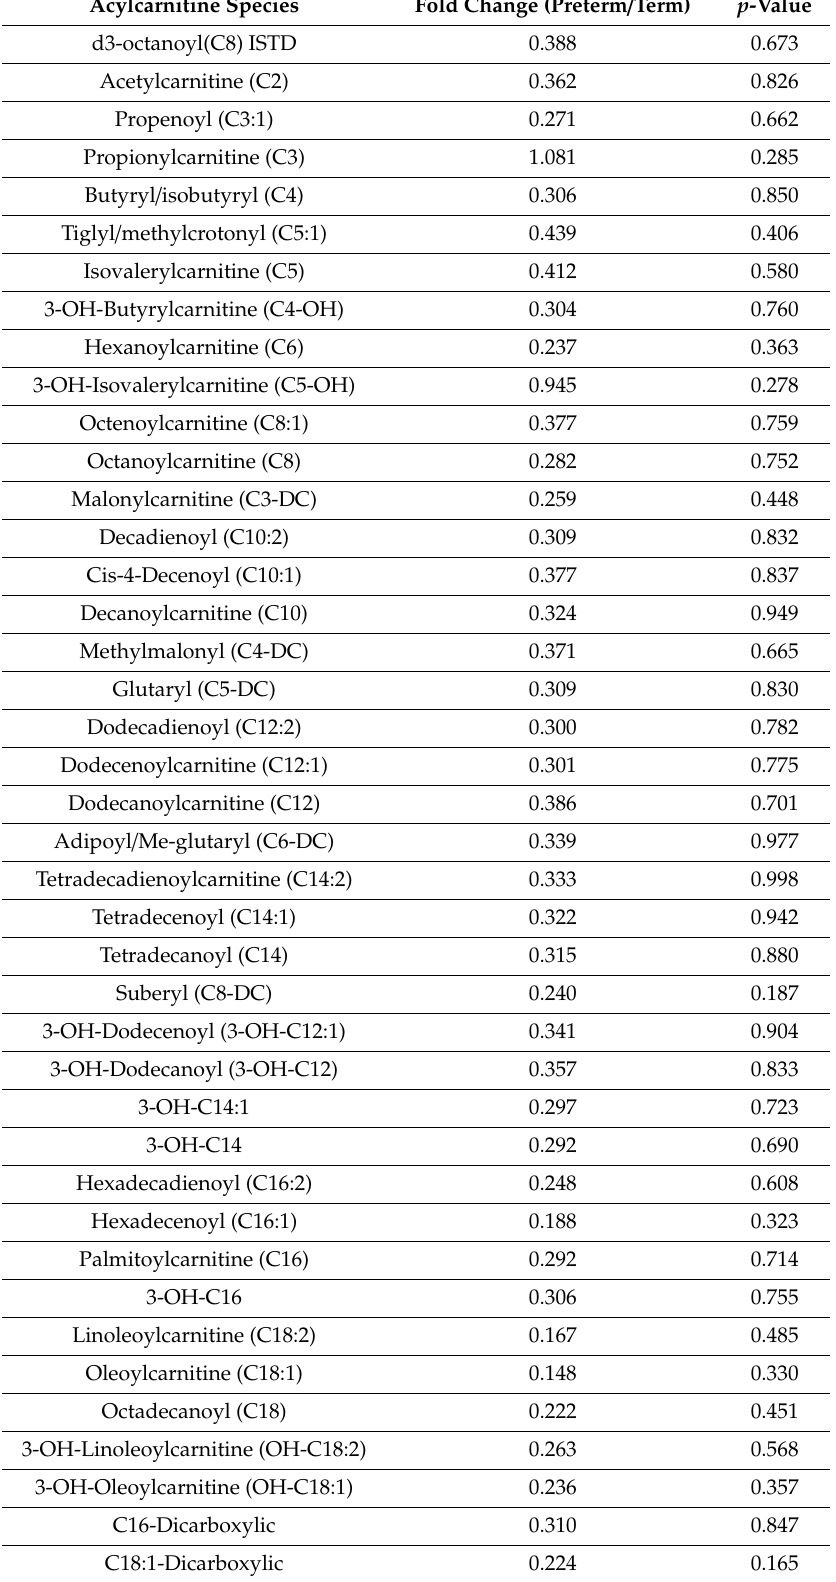
Table 8. Fold changes in acylcarnitine Rhesus monkey gestational